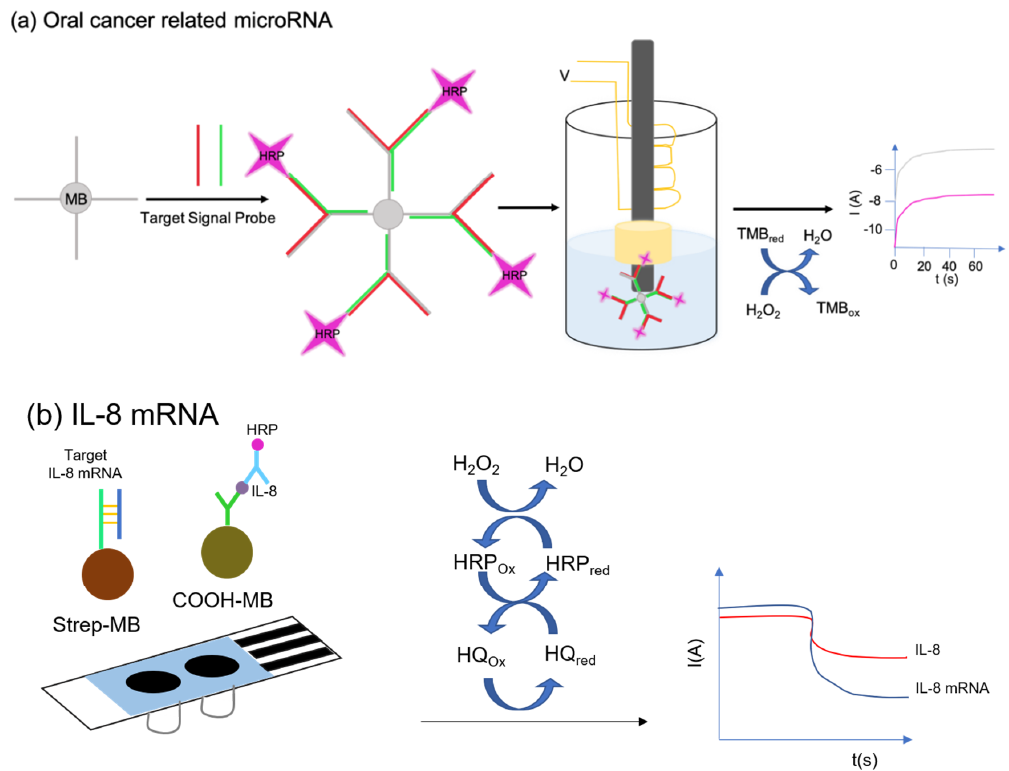
Figure3. ( a )Theprincipleofthemagnetic-controllableelectrochemicalRNAbiosensor. ( b )Themodified Figure 3. ( a ) The principle of the magnetic-controllable electrochemical RNA biosensor. ( b ) The MBs on SPdCE for the simultaneous determination of IL-8 protein and IL-8 mRNA. modified MBs on SPdCE for the simultaneous determination of IL-8 protein and IL-8 mRNA.